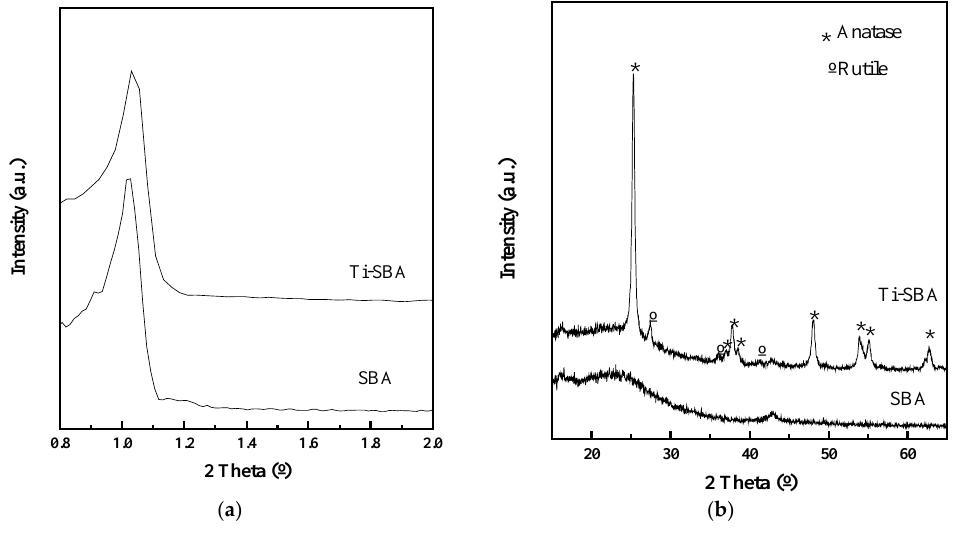
Figure 1. ( a ) Low-angle and ( b ) high-angle X-ray diffractograms of the support material.